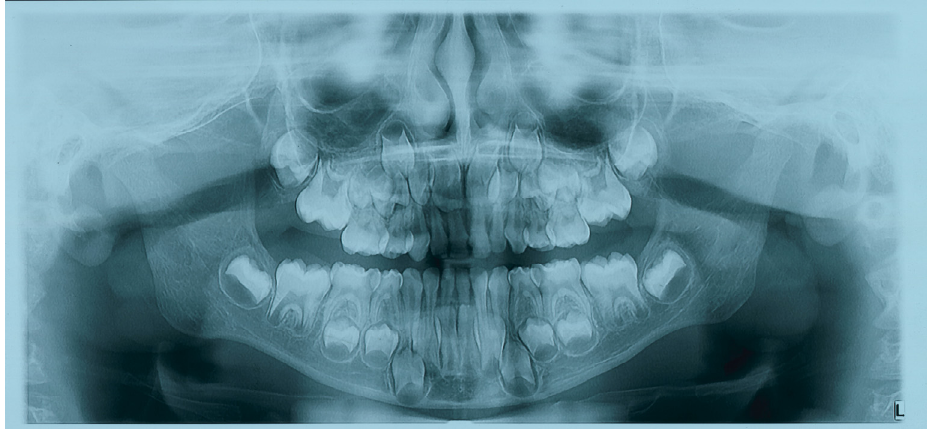
Figure 3. Previous orthopantomography showing no object in the left auditory canal. Even though the patient did not recall having inserted anything in his ear, either voluntarily or accidentally, the Orthodontist decided to refer the young patient to a specialist of the Pediatric Otolaryngology Department of the same hospital. An object was embedded in the cerumen. The ENT specialist grasped and removed the object from the auditory canal using an alligator forceps under mild sedation because of the intellectual disability of the patient. Cerumen and debris were removed with an otologic suction and loop curette. The tympanic membrane was intact after removal, and there was no significant trauma to the external canal. The foreign object was determined to be a piece of fashion jewelry with a metallic base (0.65 mm length, 0.4 mm width, 0.25 mm thickness) (Figure 4). The patient did not remember placing anything into his ear accidentally. After the removal of the foreign body, the patient underwent his orthodontic treatment and was treated with a rapid maxillary expansion to improve the nasal breathing, produce space for the eruption of lateral incisors and permanent canines, and to solve the mandibular shift. The MMO after the ENT intervention was